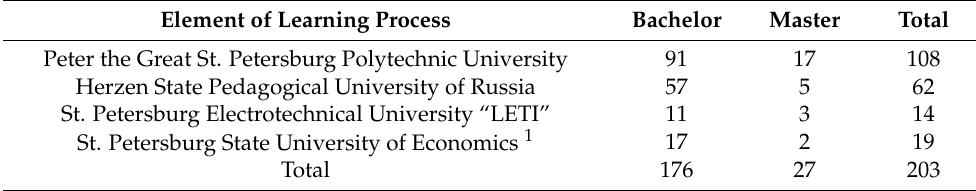
Table 1. Points awarded by students on the elements of the organization of the educational